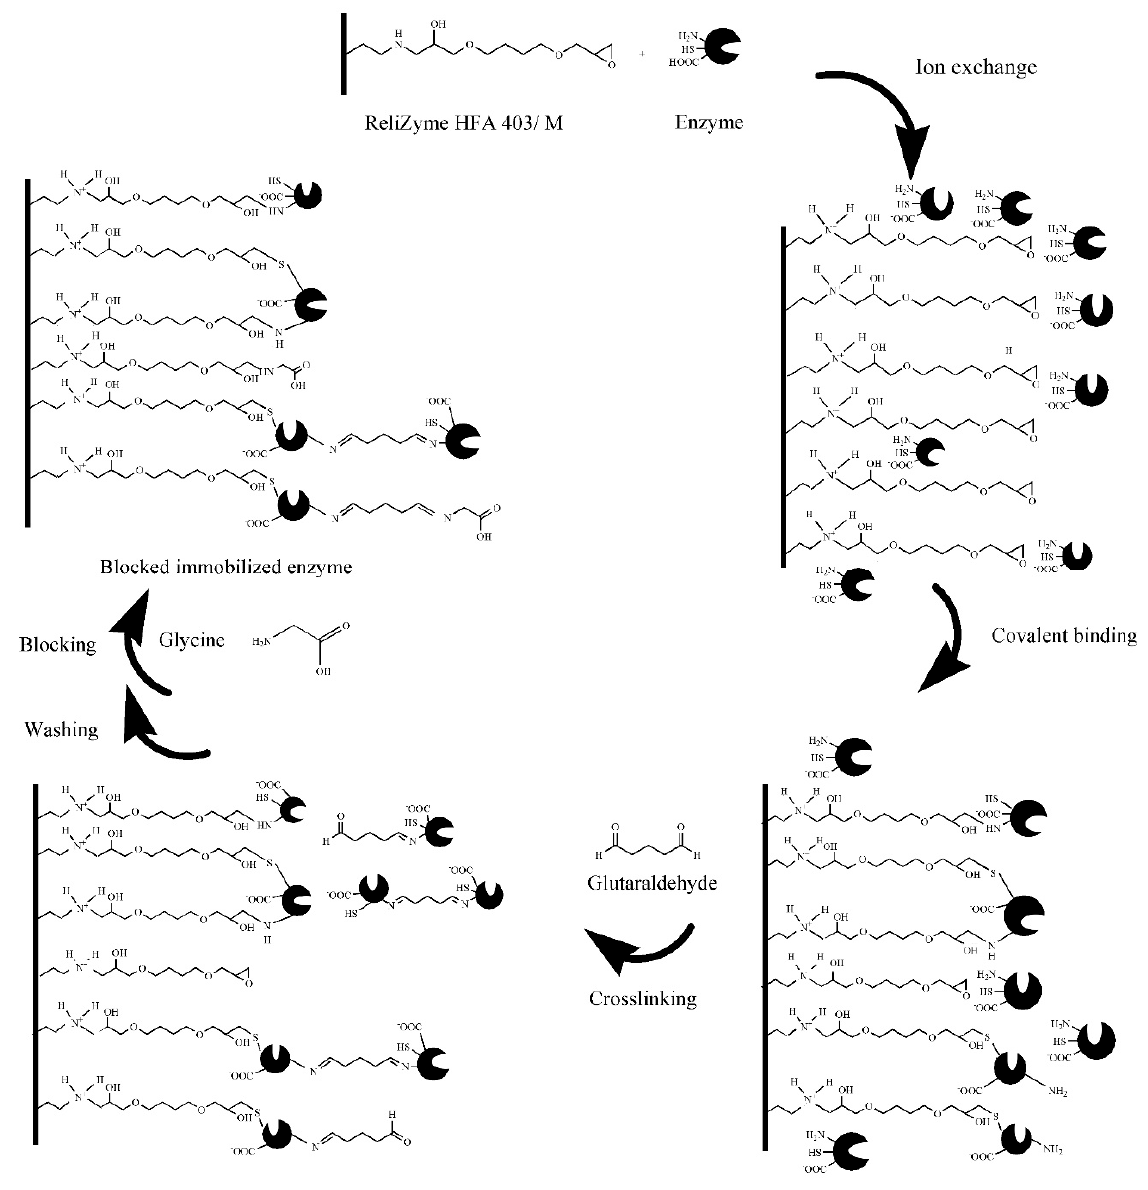
Figure 1. Schematic representation of enzyme immobilisation on HFA.